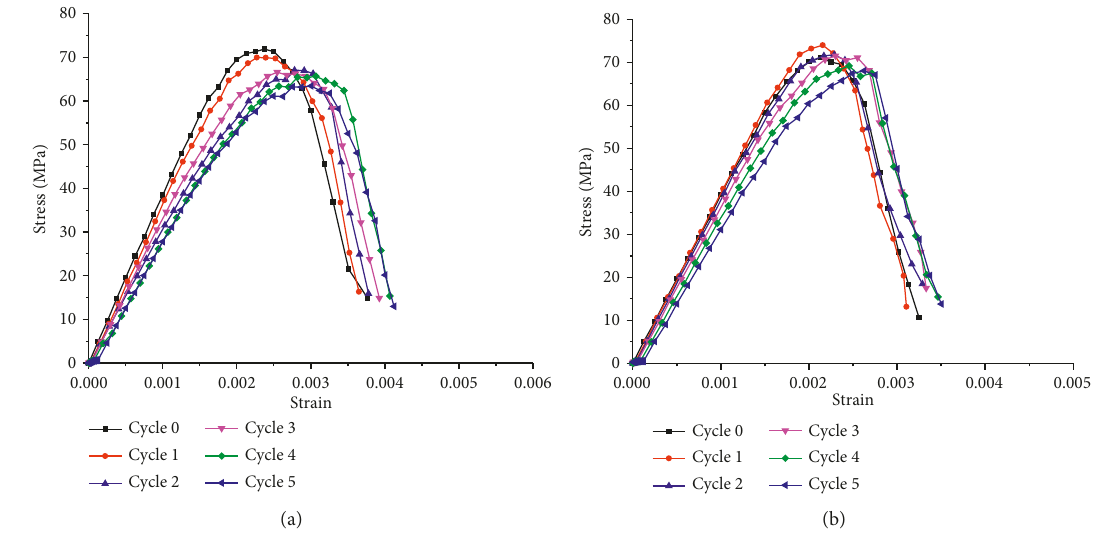
Figure 4: Stress-strain curves of C80 concrete. (a) Internal environment. (b) External environment.